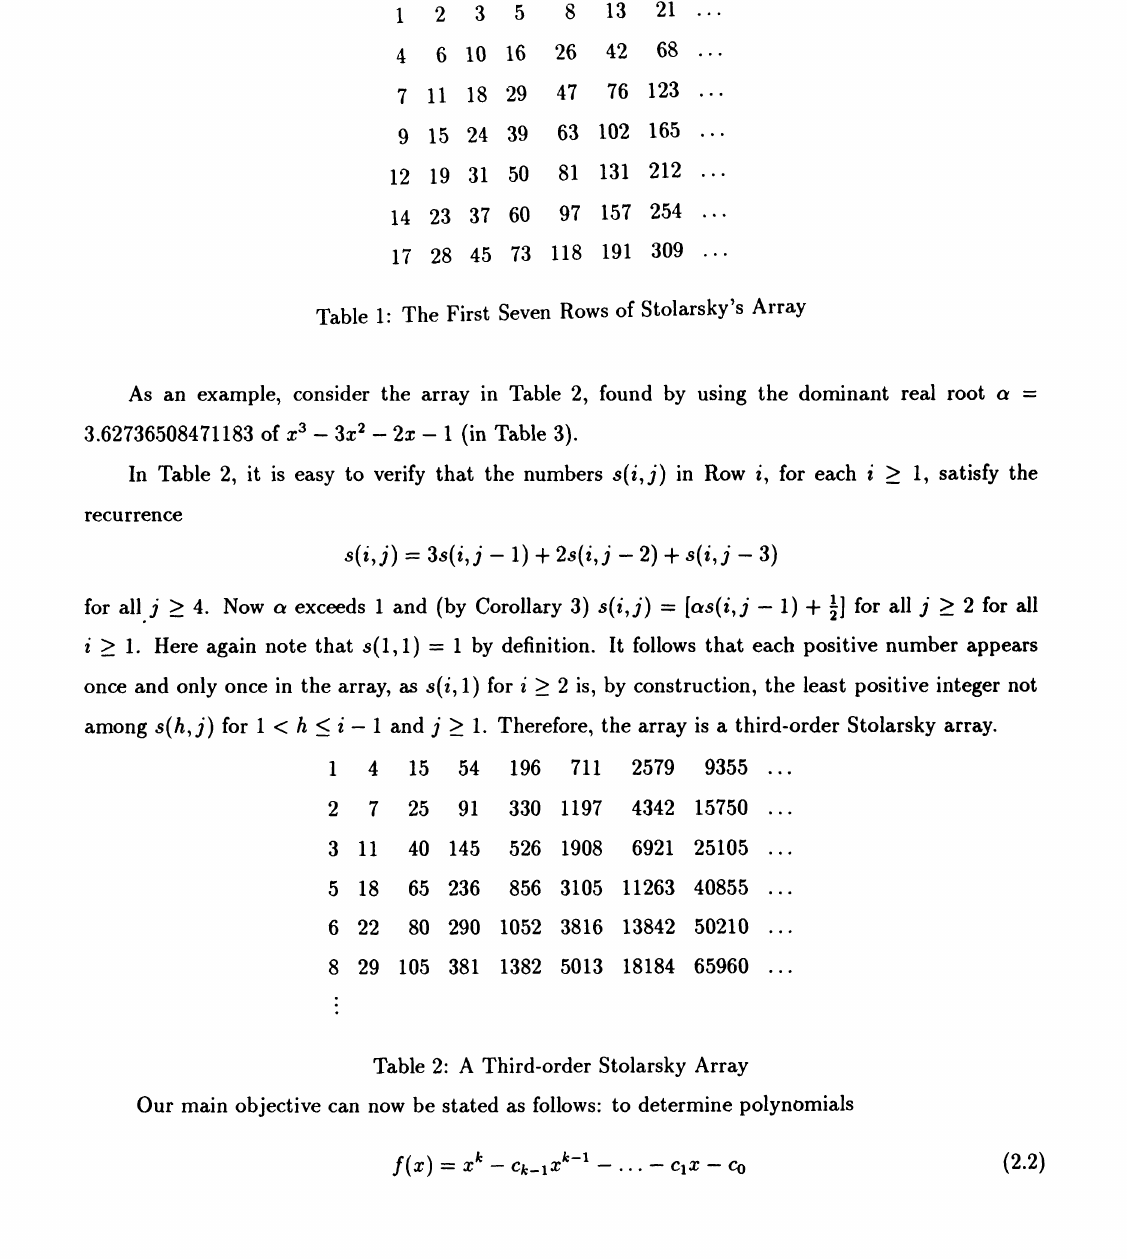
Table 2: A Third-order Stolarsky